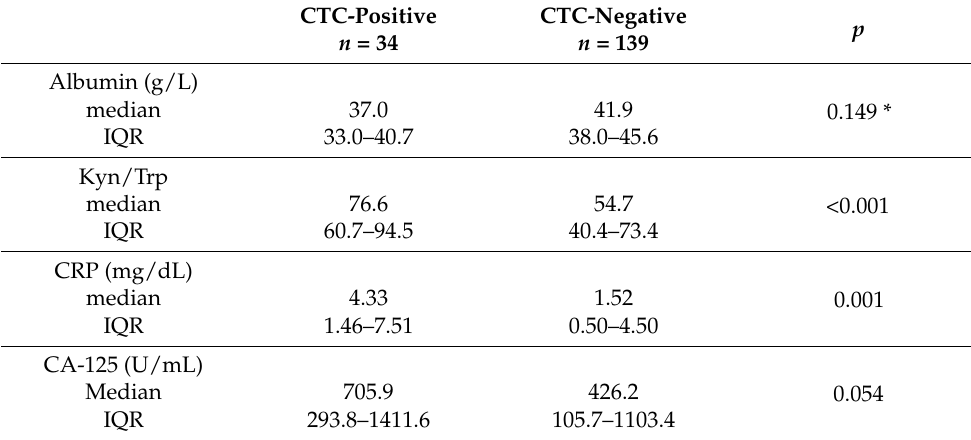
Table 3. Association of CTCs and albumin, CRP, CA-125 and the ratio of kynurenine to tryptophan levels in the blood plasma. The two-sided t -test (*) and the Mann–Whitney U -test were used to assess the association of each parameter and the presence of CTCs indicated by overexpression of the PPIC gene in the mononuclear blood cell fraction.